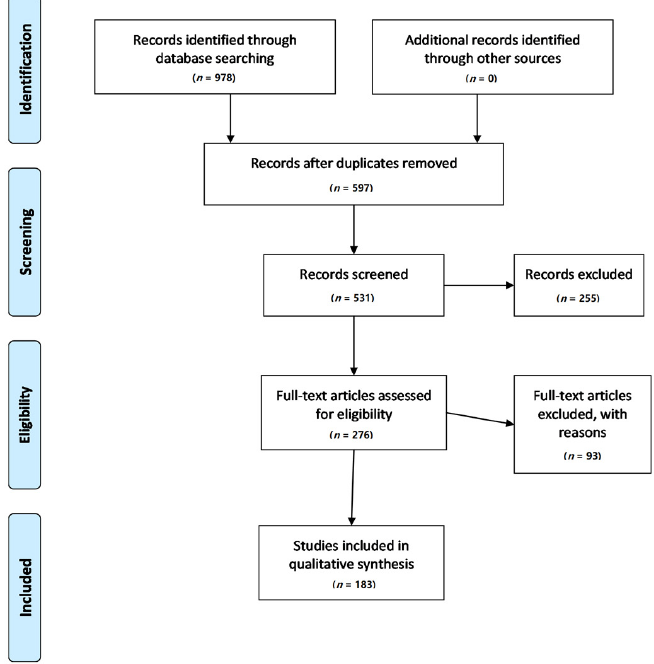
Figure 1. PRISMA flow diagram used in this systematic